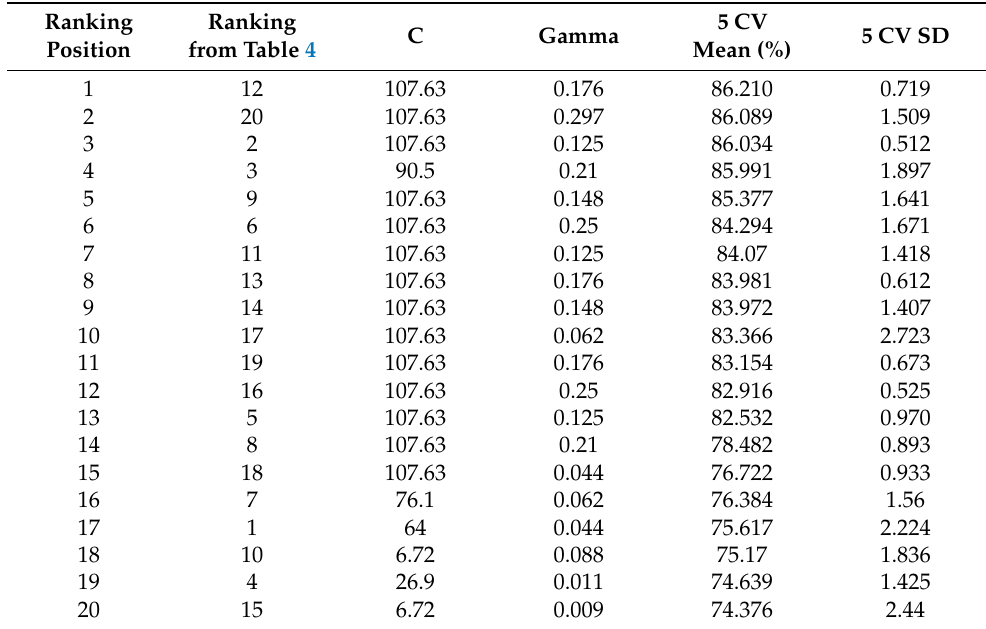
Table 8. Top 20 ranking for multiple wavelength usage for brown eggshells with hyperparameter optimization and decreased C parameter value.